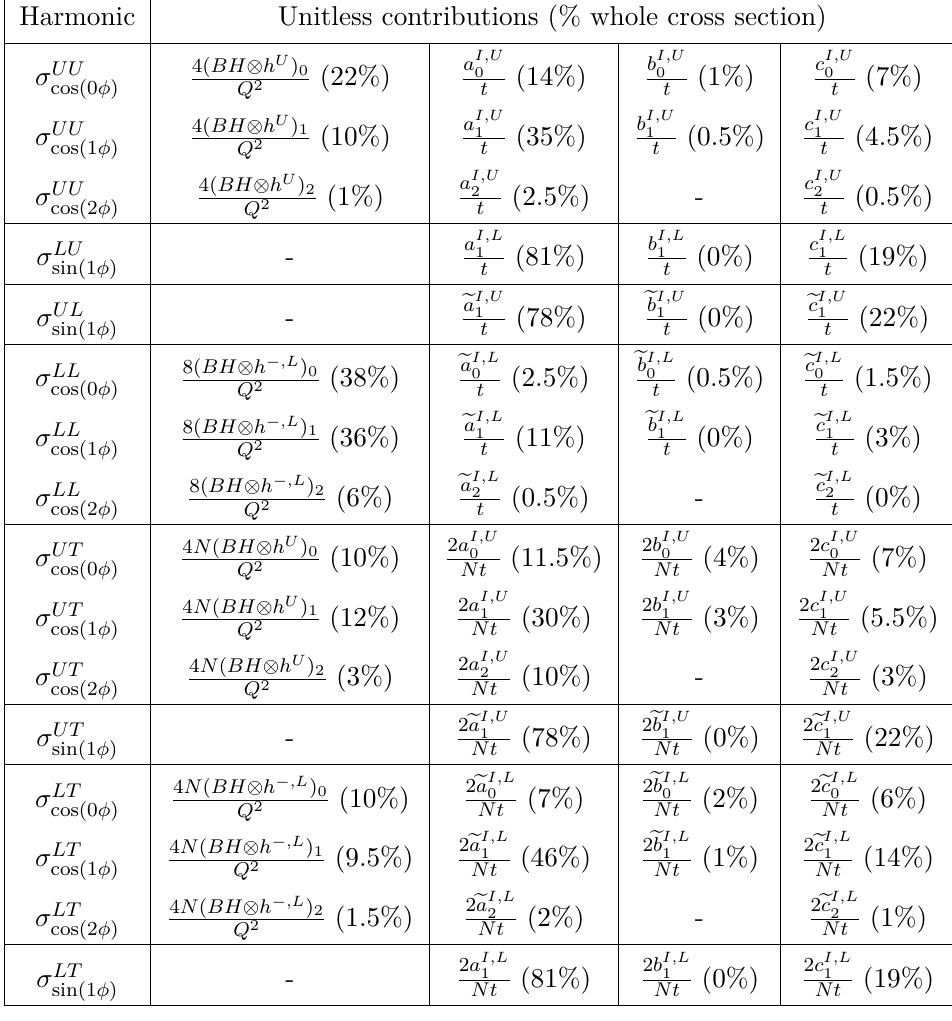
A table of numerical weights of each unit-less coefficient which contributes to all polarization harmonic cross sections. Weighting is performed over eq. (3.3). Each term in the table represents the coefficient of a certain trigonometric function that can be explicitly written in terms of the